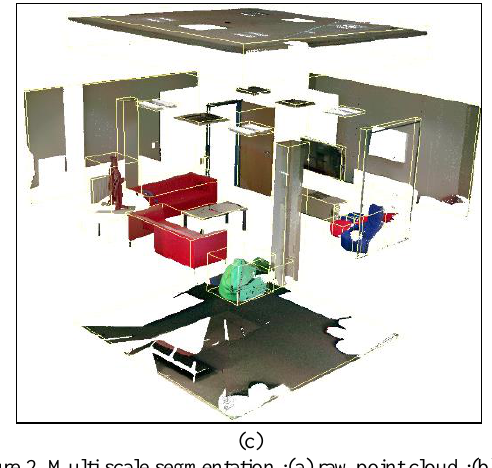
Figure 2. Multi scale segmentation :(a) raw point cloud ;(b) The point cloud segmented into a subspaces ;(c) Subspace segmented into several smaller elements.